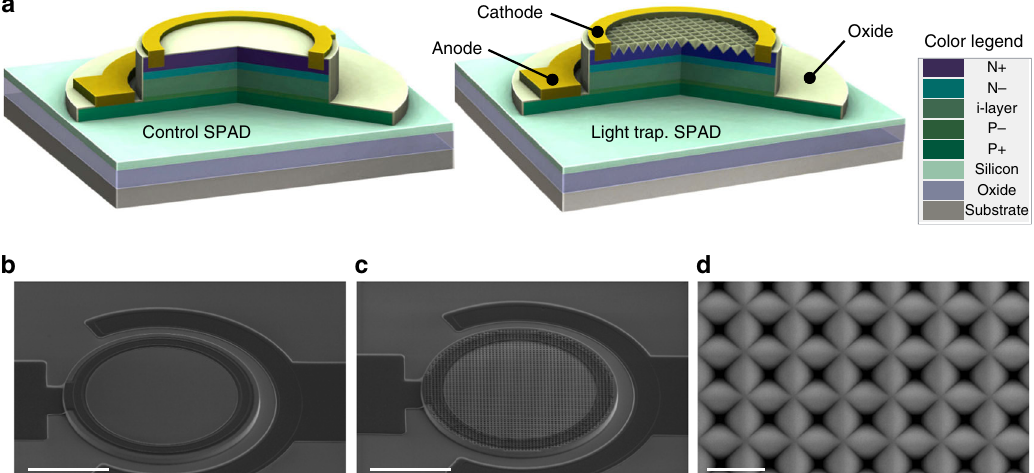
Fig. 1 Structure of light-trapping SPAD. a Three-dimensional (3D) cross-sectional schematics of layer con fi gurations of control ( left ) and light-trapping SPADs ( right ). The color legend shows the names of all the layers in both devices. The design thicknesses of layers from N+ to the bottom oxide layer of SOI substrate are sequentially listed 600, 300, 700, 200, 500, 220, and 400 nm for both devices. b , c Scanning electron microscope (SEM) images (45° view of top of structure) of control ( b ) and light-trapping SPADs ( c ) both with 50 μ m diameter. Scale bar in both, 20 μ m. d SEM image ( top-down view ) of inverse pyramid nano-structure on light-trapping SPAD. Scale bar , 1 μ